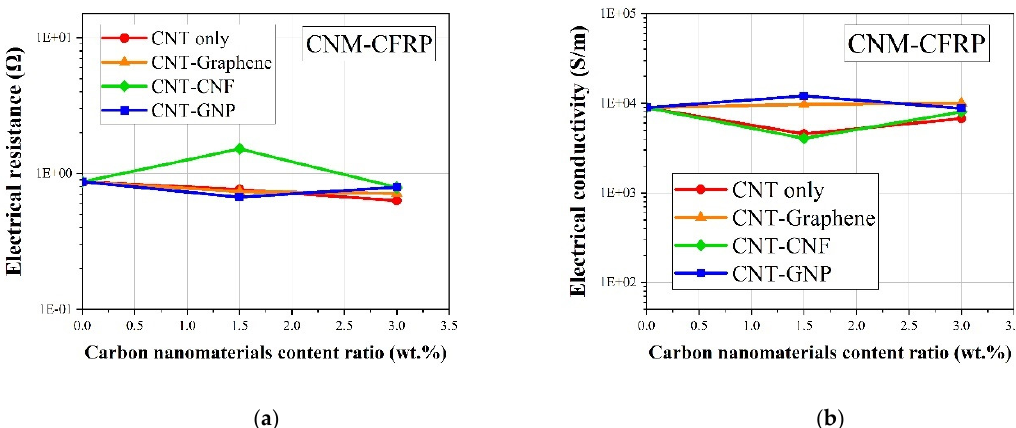
Figure 6. ( a ) The electrical resistance and ( b ) electrical conductivity of the CNM-incorporated CFRP composites.